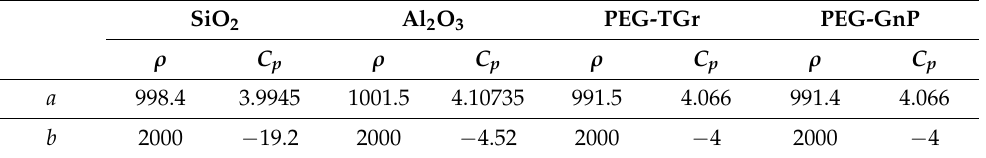
Table 4. The values of coefficients of Equation (5) for density and heat